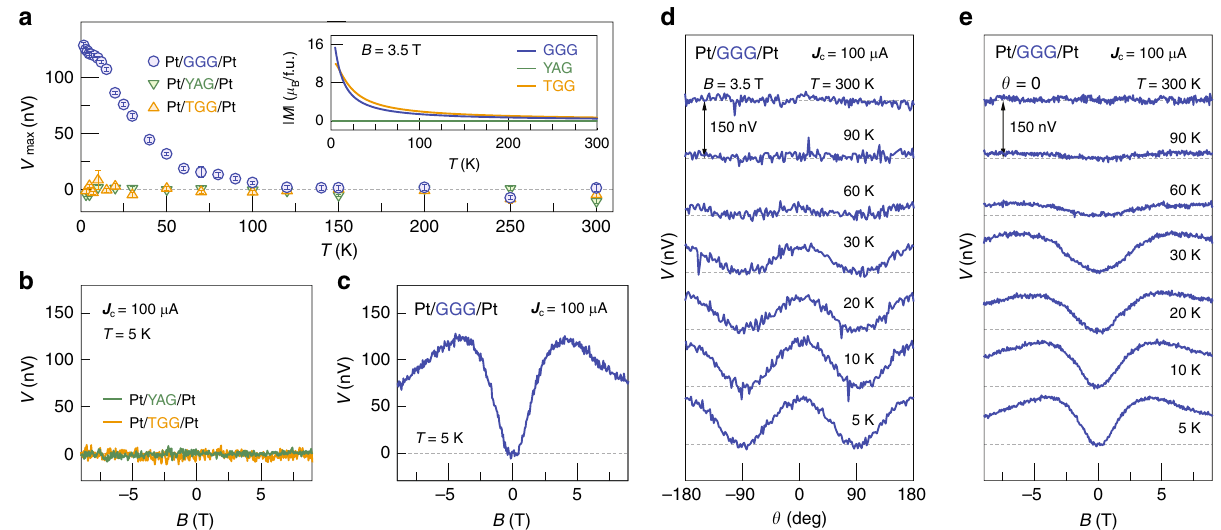
Fig. 3 Temperature and magnetic fi eld dependence of the nonlocal voltage signal. All experimental data were obtained by the same device ( d = 0.5 μ m) with a current amplitude of 100 μ A. a The temperature ( T ) dependence of the amplitude of the maximum nonlocal voltage V max for Pt/GGG/Pt, Pt/TGG/ Pt, and Pt/YAG/Pt obtained from a sinusoidal fi t to the magnetic fi eld angle θ dependences of V at B = 3.5 T. The error bars represent the 68% con fi dence level (±s.d.). T he inset shows the T dependence of the magnetization M of GGG, TGG, and YAG at B = 3.5T. b , c Comparison between V for Pt/YAG/Pt, Pt/TGG/Pt, and Pt/GGG/Pt. b ( c ) shows the B dependences of V for Pt/YAG/Pt and Pt/TGG/Pt (Pt/GGG/Pt) at 5 K for | B| < 9 T. d , e The θ and B dependence of V for Pt/GGG/Pt at various temperatures. We varied θ by rotating the fi eld at B = 3.5 T in the z – y plane. The fi eld was changed from − 9 T to 9 T at θ ¼ 0 for the B